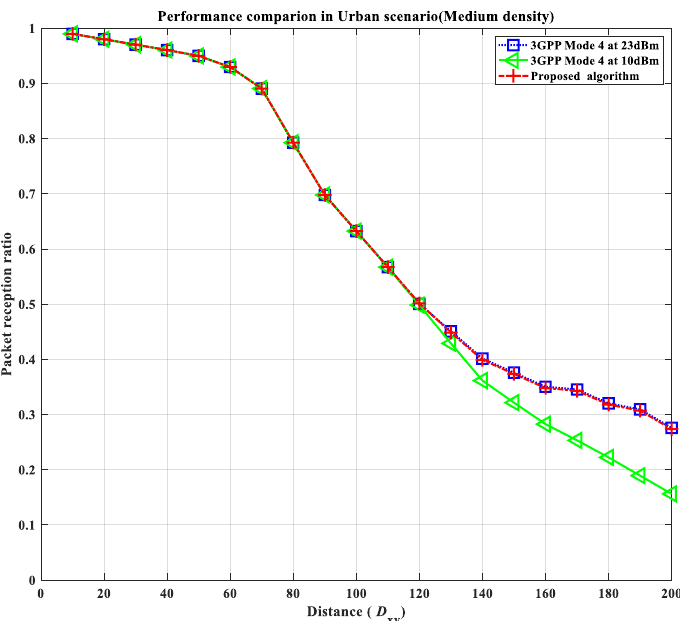
Figure 9. Packet reception ratio as a function of the distance between transmitter and receiver ( D xy ) in an urban scenario with medium tra ffi c